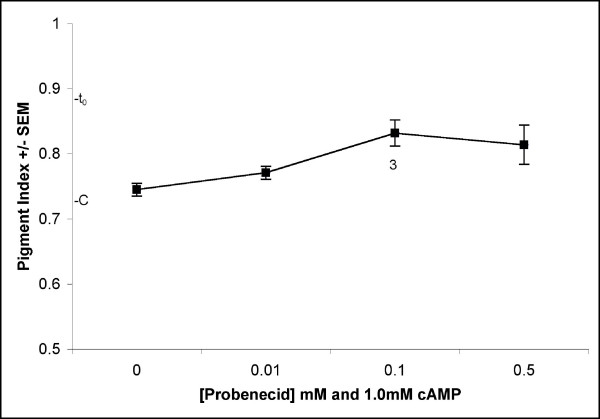
Effects of probenecid on cAMP-induced aggregation. The t0 pigment index was 0.88 ± 0.03 (n = 4) after a 30 minute preculture. The control, containing 1.0 mM cAMP and DMSO, had a pigment index of 0.72 ± 0.03 (n = 4, except where noted).